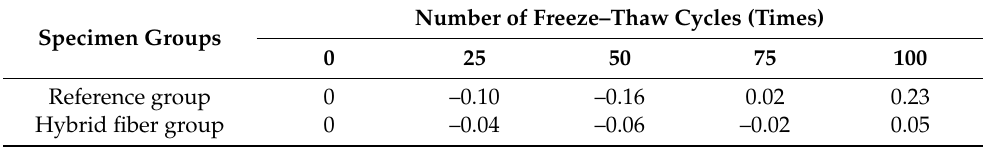
Table 9. Concrete mass loss results after freeze–thaw cycles (%).